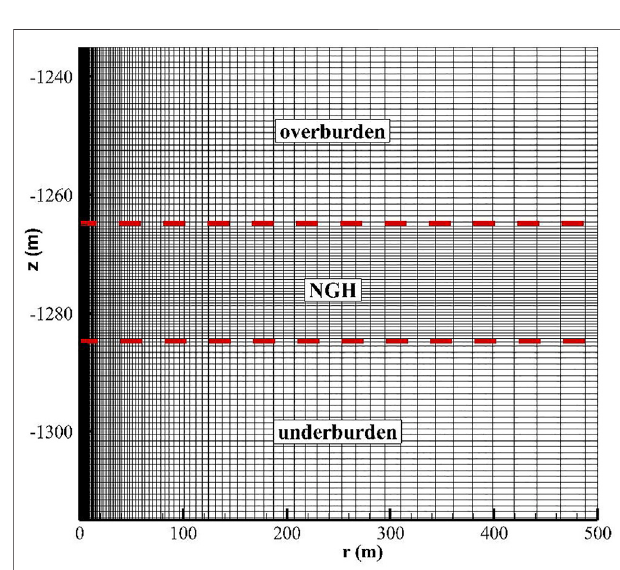
FIGURE 4 | Schematic of model